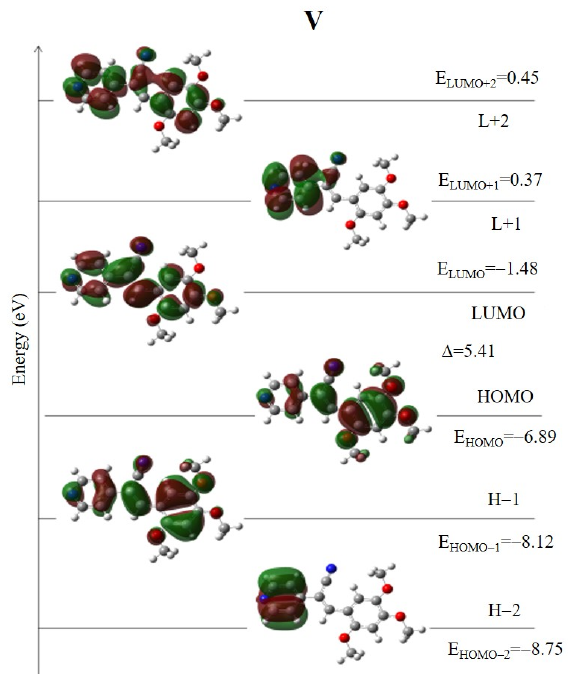
Figure 4. Frontier molecular orbital diagrams of I – V compounds.